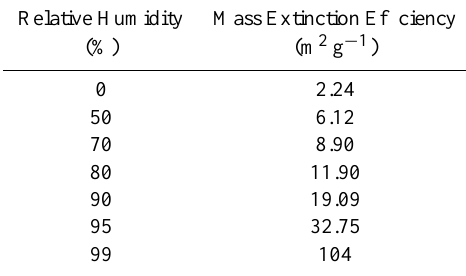
Table 1. Mass extinction efficiency values used in GEOS-Chem for sulfate aerosols at given relative humidity values.